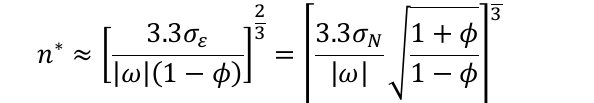
Figure 2 is a time series of monthly mean cloud amount for the entire region over the time period. The grey area represents the uncertainty and the solid black line the mean. Daily mean values are